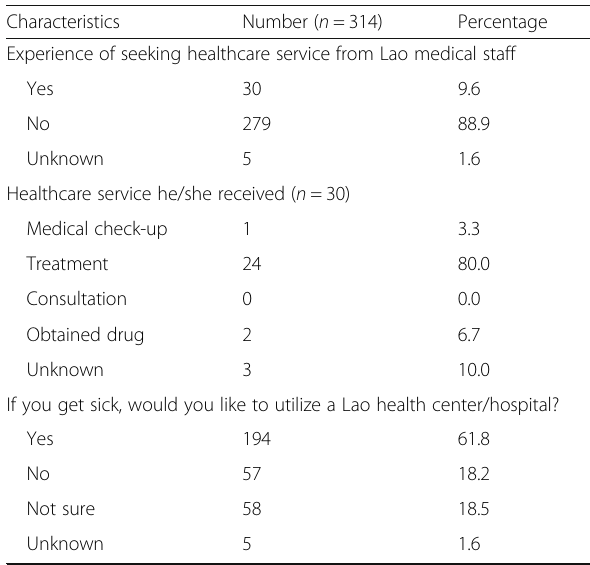
Table 5 General healthcare-seeking behavior of the study